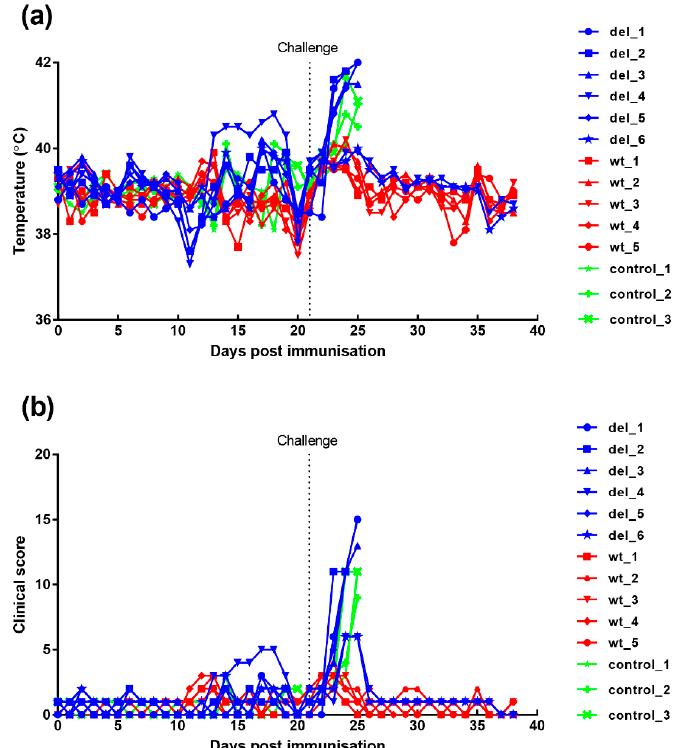
Figure 4. Clinical scores and temperatures of pigs following immunisation with OURT88/3 or OURT88/3 Δ I329L and challenge with virulent virus. Panel ( a ) shows temperatures and panel ( b ) scores all clinical signs on the y-axis. Days post-immunisation are shown on the x-axis. The blue symbols and signs show those pigs immunised with the OURT88/3 Δ I329L virus (del_1–6) and red with OURT88/3 (wt_1–5). Information on the control pigs is shown in green (control_1–3).